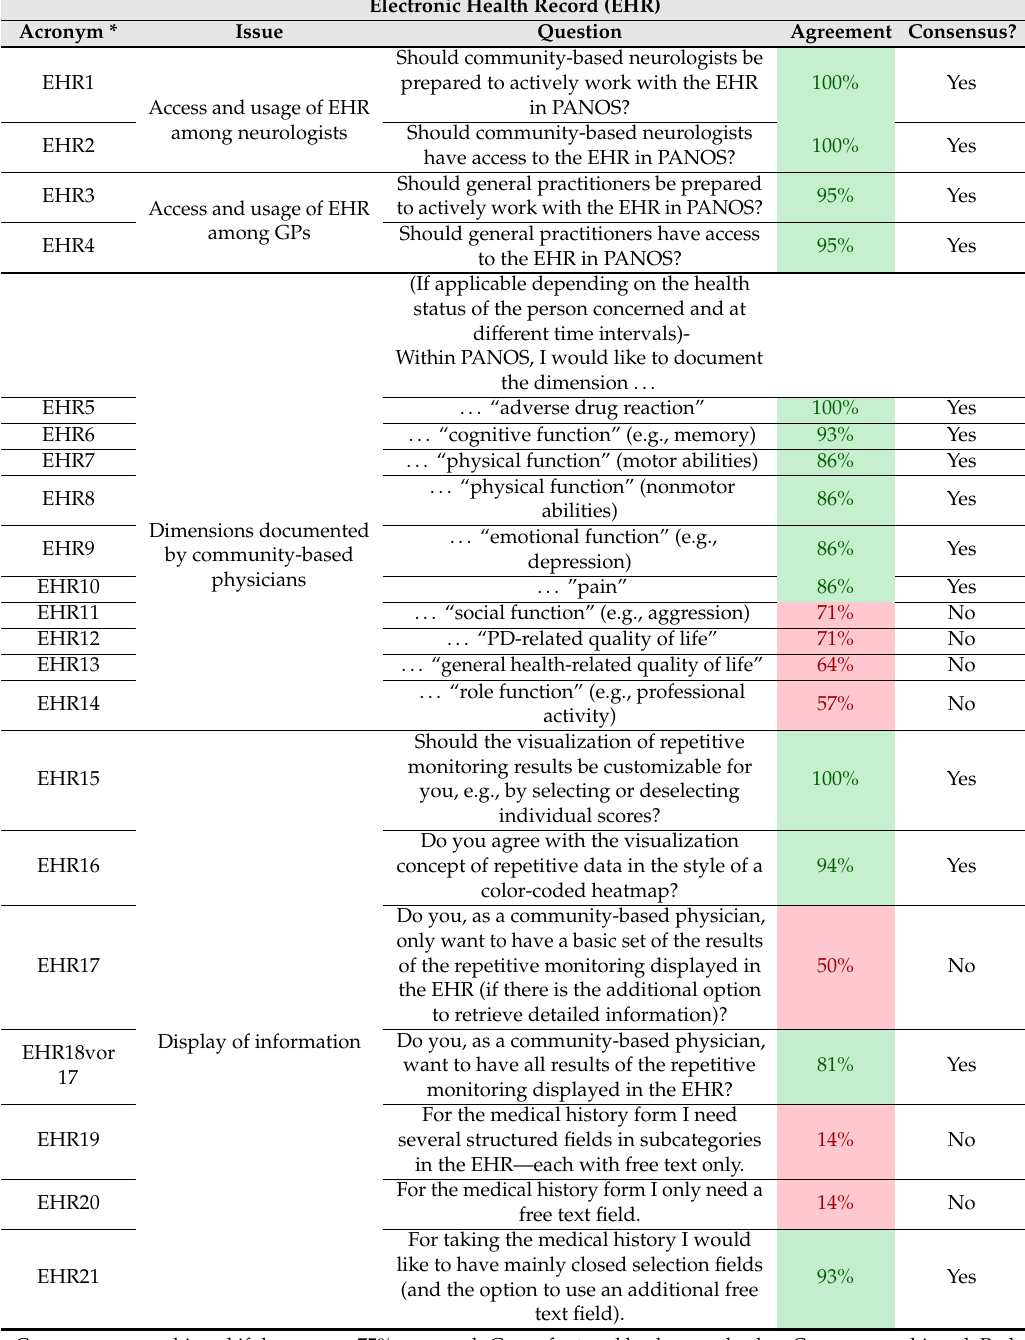
Table 5. Results of TED voting—electronic health